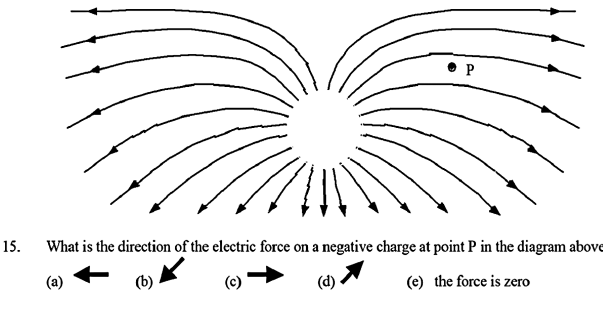
CSEM.FIG. 3. Q15 on the